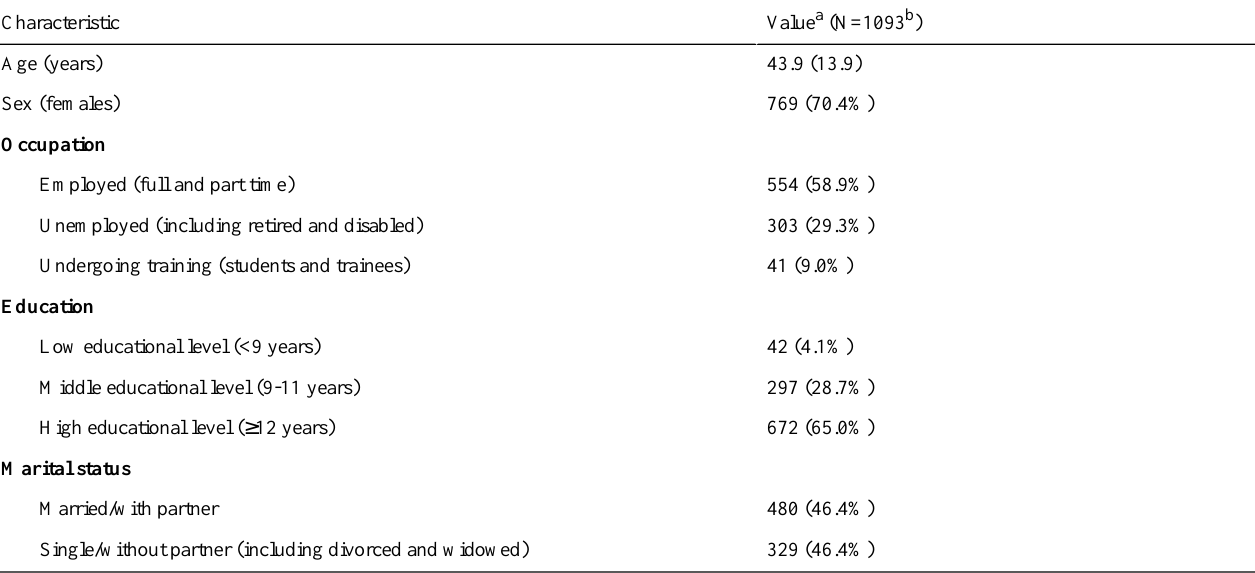
Table 2. Sample sociodemographic